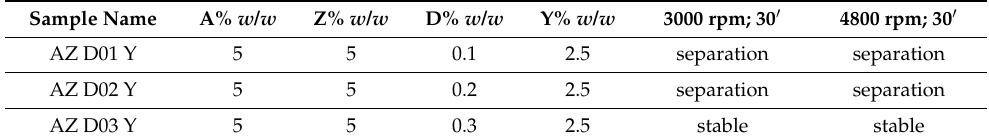
Table 8. Stability test results of emulsions formulated with Zea mays starch A and zinc oxide Z (total solid phase at 10% w / w ), the oily phase at 10% w / w , a mixture of pigments Y at 3% w / w , and diutan gum D at increasing concentrations (0.1–0.2–0.3% w / w ).